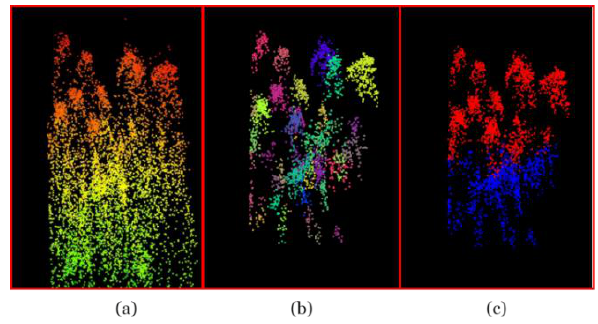
Figure 8 Mean shift-based ear detection results. The size of the ears is retained (a) Raw point cloud, color coded based on height value (b) Mean shift-based segmentation results with each segment displayed with a random color (c) Ear classification where the red segments are the extracted ears (crops of age 225 days).